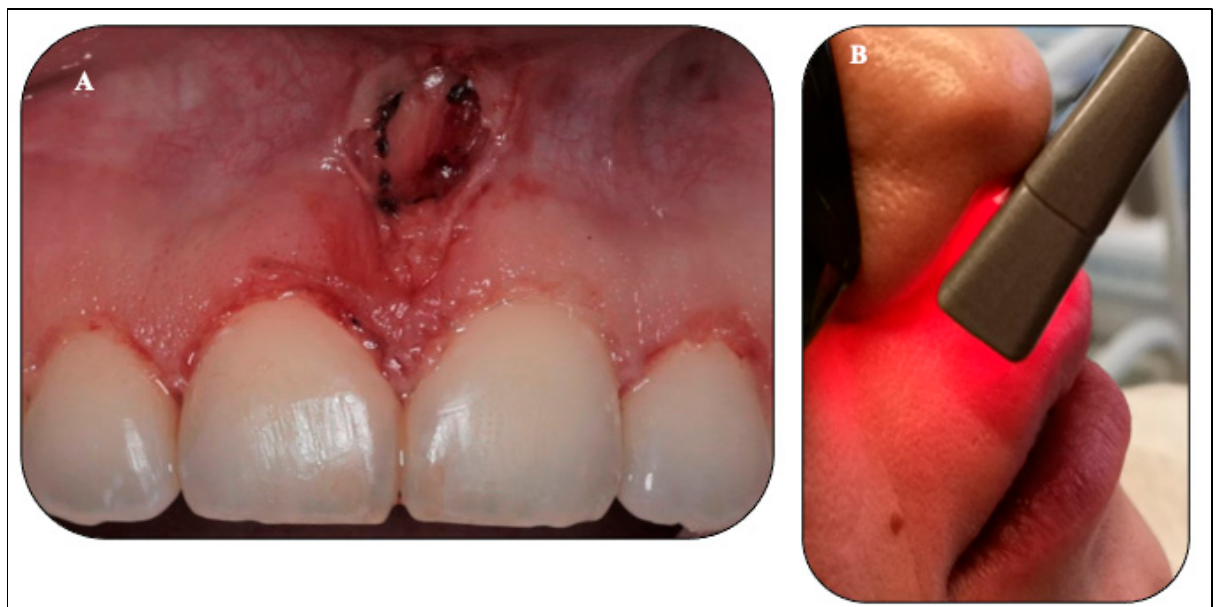
Figure 7. ( A,B ) . Clinical photo ( A ) was taken immediately following laser treatments, illustrating the rhomboid shape of the new position of the upper midline and the gingival re-contouring of the upper incisor teeth. Photo ( B ) is an extra-oral application of λ 940 nm laser-PBM in the region of the treated